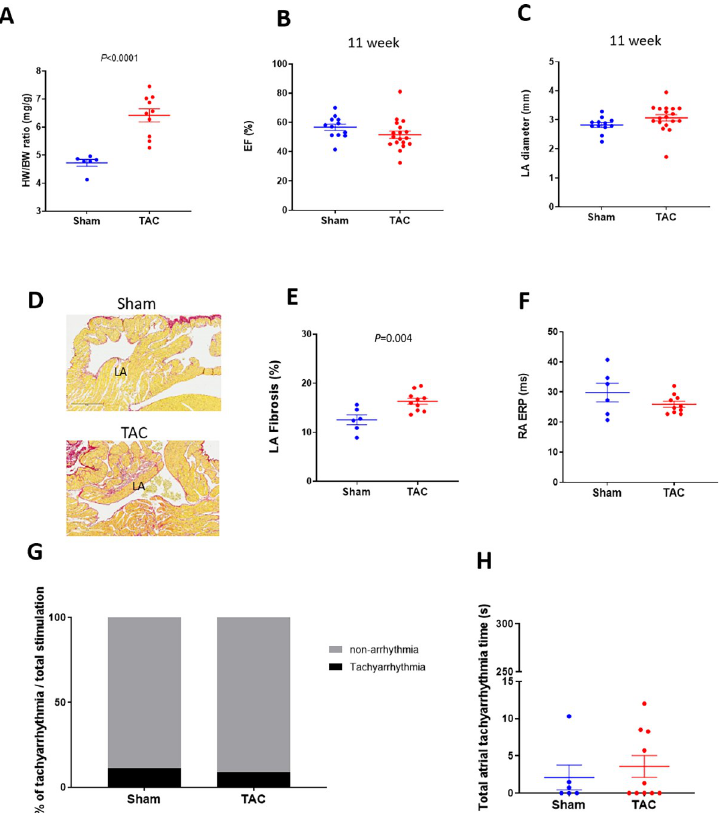
Fig 2. Heart phenotypes and burst pacing-induced tachyarrhythmia in TAC mice. A: Heart weight / body weight ratio in sham and TAC mice (n = 6 and 10, respectively) at 16 weeks after surgery. Echocardiographic evaluation of EF (B) and LA diameter (C) in sham and TAC mice (n = 12 and 18, respectively) at 11 weeks after surgery. D: Representative images of fibrosis staining (Picrosirius red) of the sham and TAC surgery mouse atria at 16 weeks after surgery. E: LA fibrotic area in sham and TAC mice (n = 6 and 10, respectively) at 16 weeks after surgery. F: RA ERP in sham and TAC mice (n = 6 and 12, respectively) at 16 weeks after surgery. Each point indicates individual animal data, and lines represent mean ± SEM. G: % of positive atrial tachyarrhythmias from total burst pacing stimulations in sham and TAC groups at 16 weeks after surgery. H: Cumulative atrial tachyarrhythmia time in sham and TAC groups (n = 6 and 10, respectively). Each point indicates individual animal data, and lines represent median ±